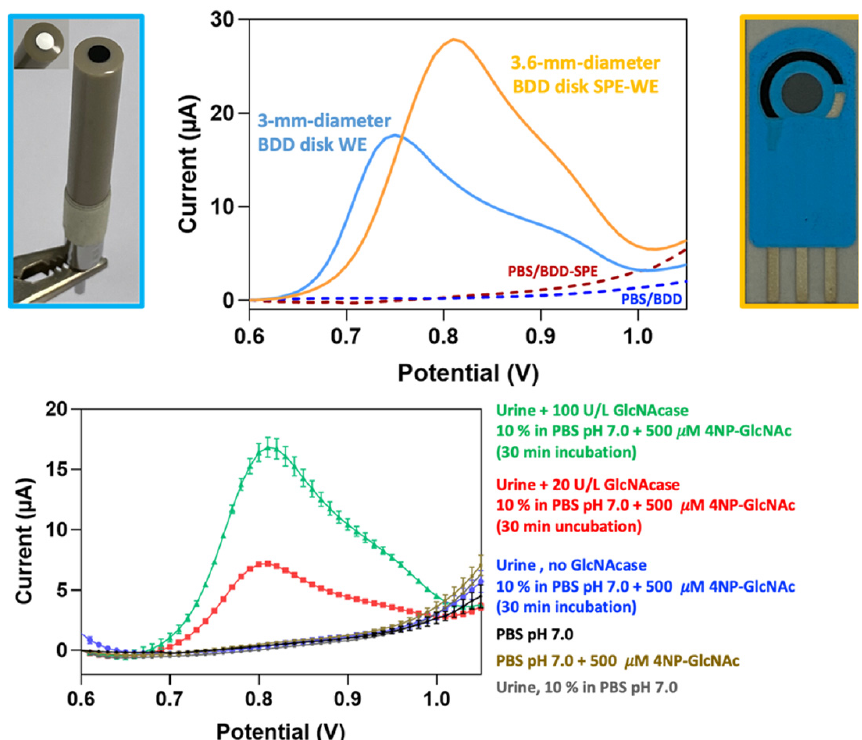
Figure 6. Application of screen-printed boron-doped diamond disk electrodes (BDD SPEs) to urinary N-acetylglucosaminidase (GlcNAcase) voltammetry. Comparison of the DPVs of a standard rod-type BDD disk electrode in 0.1 M PBS, pH 7.0 (top, dark blue trace) and in 0.1 M PBS, pH 7.0 supplemented with 500 µ M 4NP (top, light blue trace) with the DPVs of a BDD SPE in 0.1 M PBS, pH 7.0 (top, red trace) and in 0.1 M PBS, pH 7.0 supplemented with 500 µ M 4NP (top, orange trace). DPV assessment of unmodified urine (bottom, blue trace) and urine with medium (20 U/L, bottom, red trace) and high (100 U/L, bottom, green trace) added concentrations of GlcNAcase. DPVs were acquired in 0.1 M PBS, pH 7.0 with 0.5 mM GlcNAc-4NP 30 min after the addition of 300 µ L of a particular urine sample to 2700 µ L of buffered electrolyte and visualized 4NP release through the concentration-dependent action of GlcNAcase on the labelled substrate with progressively increasing anodic peak currents. The black and olive-colored traces refer to DPVs in 0.1 M PBS, pH 7.0 and in 0.1 M PBS, pH 7.0 with 0.5 mM GlcNAc-4NP but no GlcNAcase, respectively. Parameters for DPV acquisition were as listed in Figure 2.